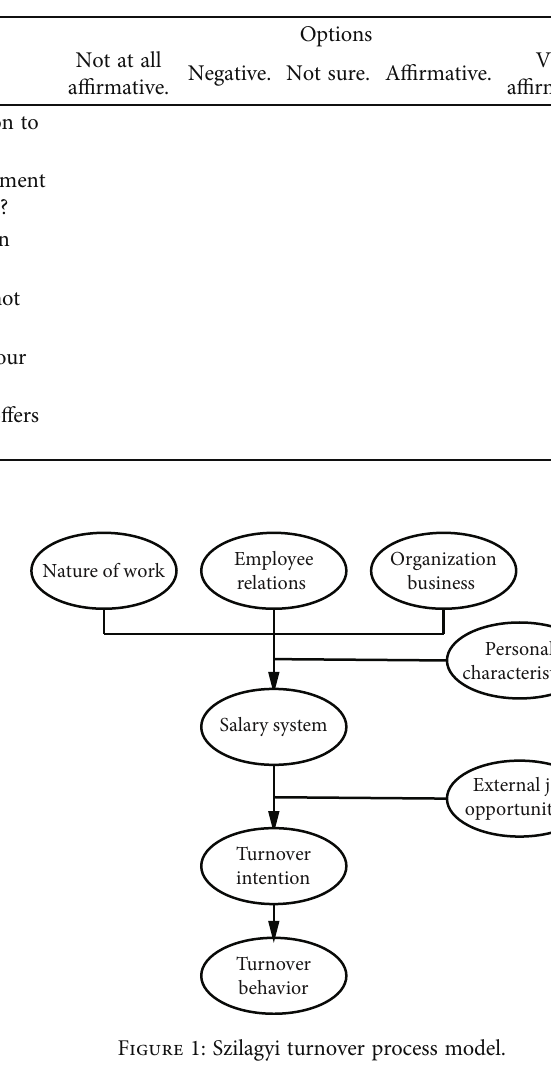
Table 3: Turnover intention scale.